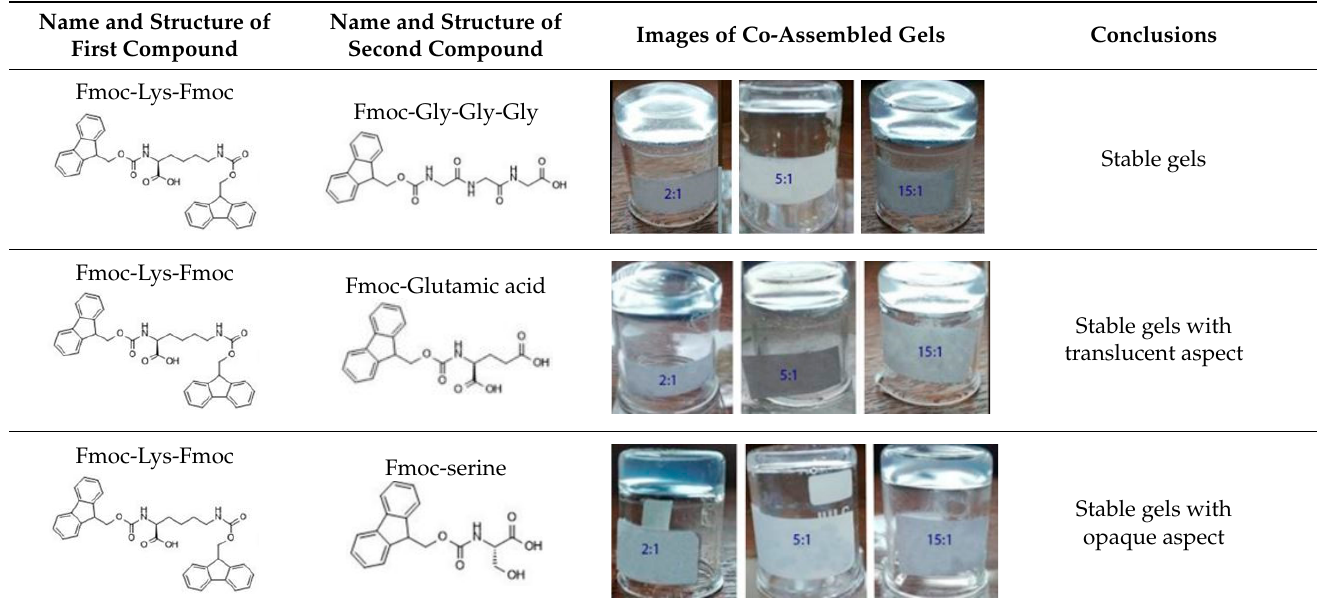
Table 2. Name and structure of compounds used in the co-assembled process.